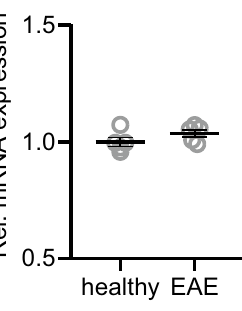
healthy EAE Figure 5. TRPM4 mRNA expression is unchanged in cortical neurons from healthy and EAE mice. Cortical nuclei from healthy and EAE-induced mice were sorted by NeuN immunoreactivity. TRPM4 expression levels were assessed by quantitative PCR. n = 5; unpaired 2-tailed t-test, p =